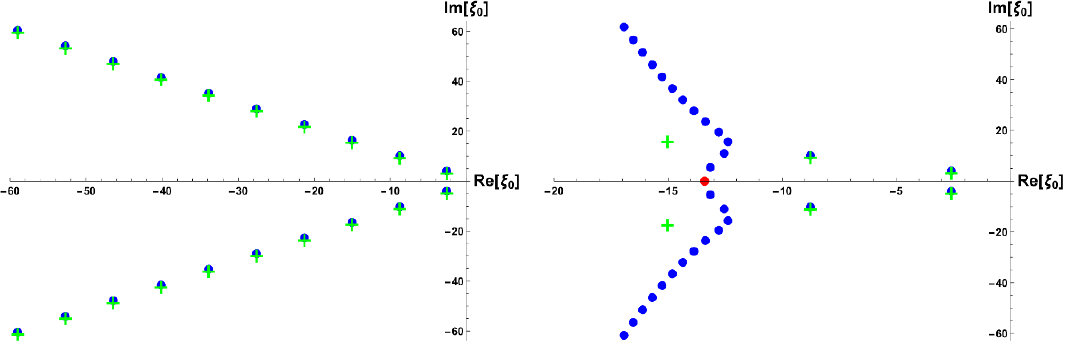
Figure 13 . Positions on the Borel plane of leading singularities (cid:24) 0 closest to the origin for (cid:10) ( B ) are given by solid circles for s = 0 (left panel) and s = 10 (cid:0) 4 (right panel). Crosses correspond to QNM frequencies ! QNM ( T ) = ^ ! QNM T and (cid:24) 0 = (cid:0) i ^ w QNM for (cid:1) = 2 bulk scalar for corresponding s . Red solid circle characterizes the location of the